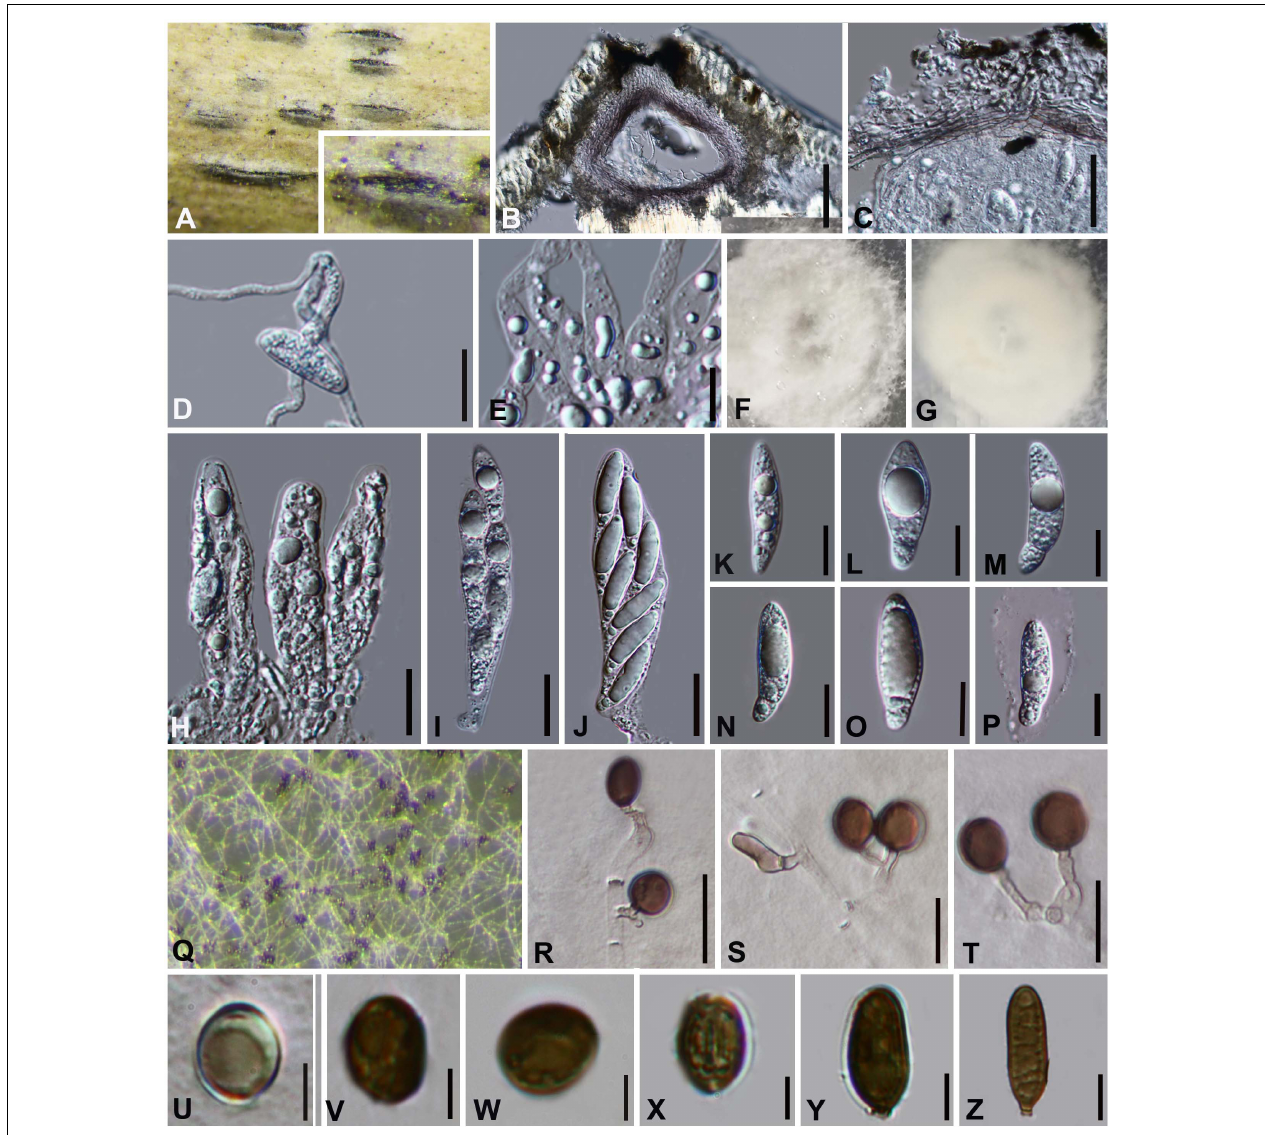
FIGURE 4 | Arthrinium septatum (HKAS 111960, holotype) . (A) Appearance of stromata on bamboo host. (B) Vertical section of stroma. (C) Peridium. (D) Germinating ascospore. (E) Paraphyses. ( F , G) Culture. (H–J) Asci. (K–P) Ascospore. (Q) Colony on PDA producing conidia masses. (R–T) Conidiophore and conidiogenous cells. (U–X) Conidia. (Y,Z) Sterile cell. Scale bars: (B) = 50 µ m. (C,D) = 25 µ m. (E) = 10 µ m. (H–J) = 20 µ m. (K–P) = 10 µ m. (R–T) = 10 µ m. (U–Z) = 5 µ m.